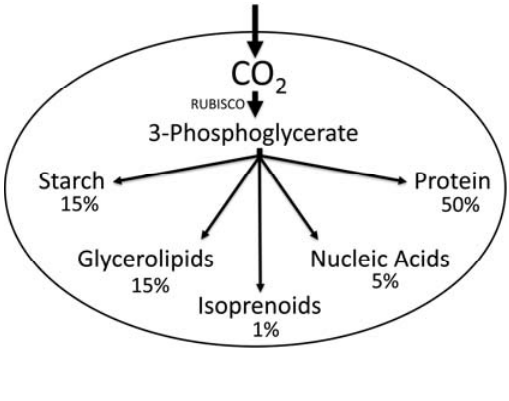
Figure 1. General overview of carbon partitioning with approximate chemical composition in % of dry weight in a green algal cell [9]. Note that the amounts of the different chemicals, such as protein, starch, and lipid, are highly variable depending on the growth conditions and